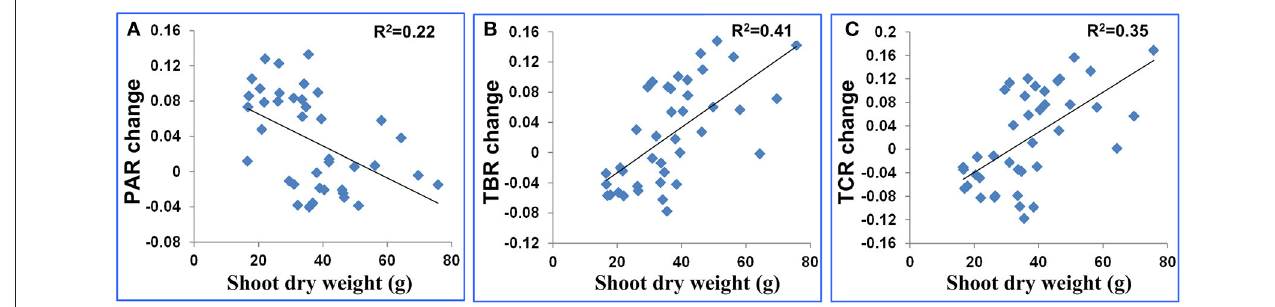
FIGURE 4 | Scatter plot for plant dry weight after stress (g) and (A) the PAR change, (B) TBR change and (C) TCR change. The feature change was defined as feature value after stress minus feature value before stress.